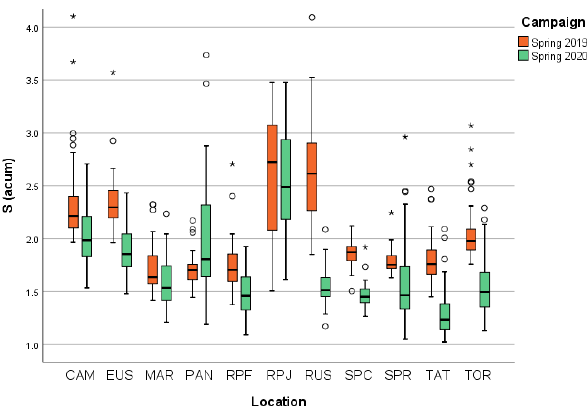
Figure 5: Sharpness distributions at the 11 London locations (for Location IDs, see Table 1) before and during the lockdown measures implementation